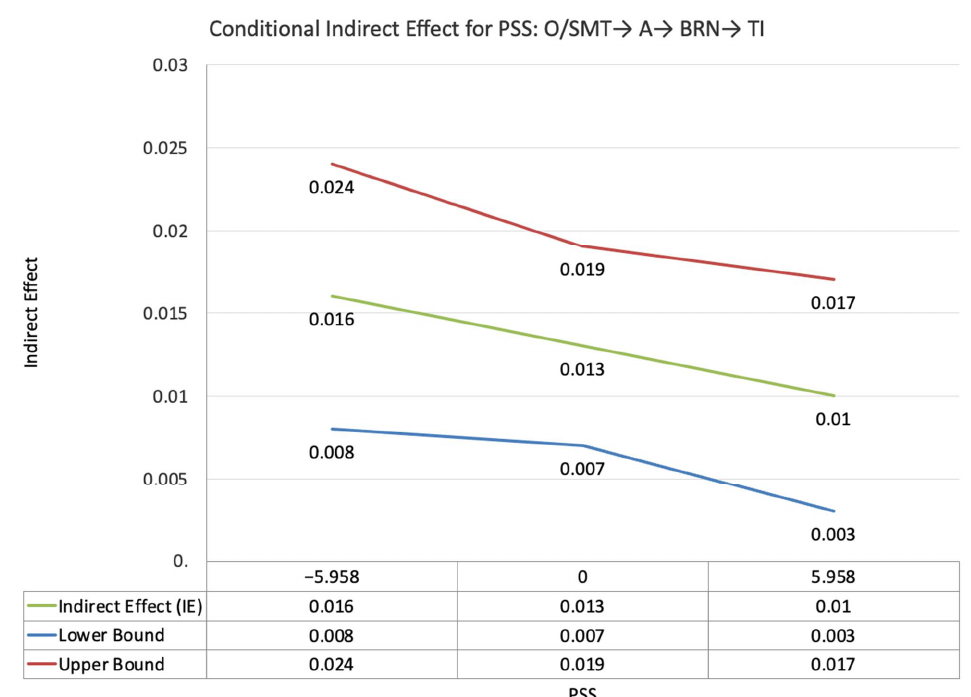
Figure 2. Conditional indirect effects of the difference between other-PMIEs compared to the control group on turnover intentions at low, average and high levels of perceived supervisor support, through autonomy satisfaction and burnout.